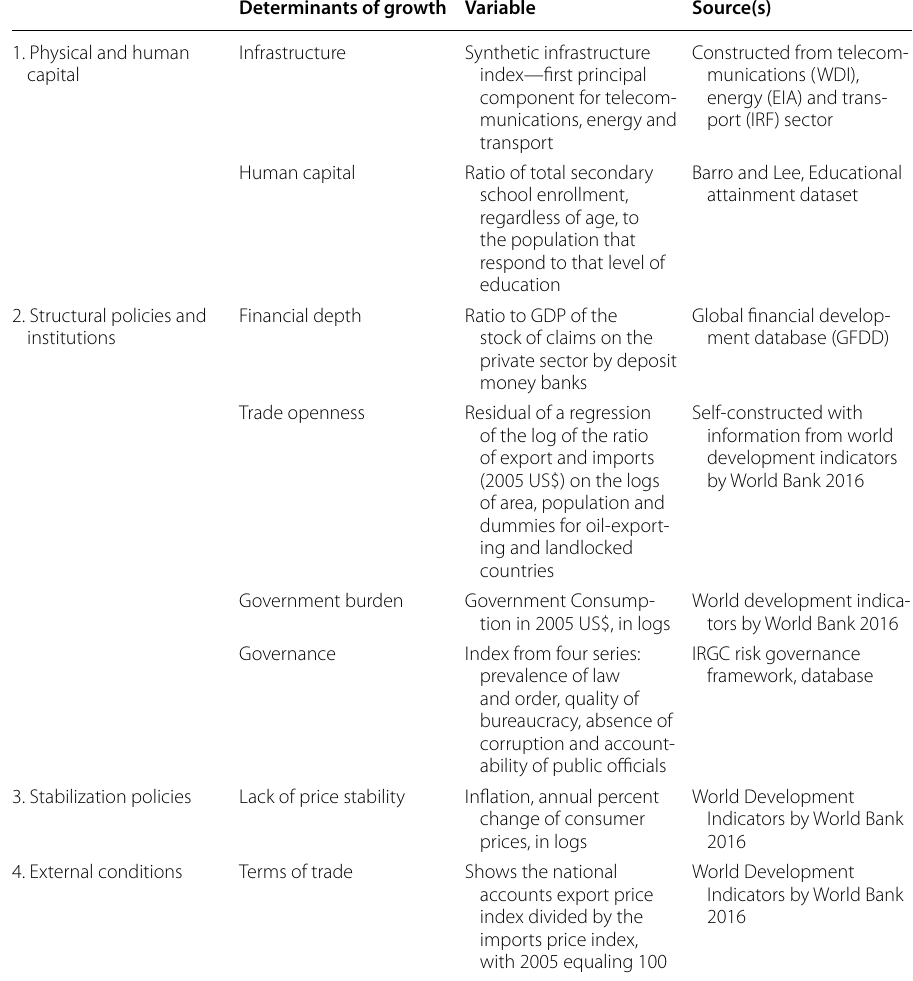
Table 2 Standard set of growth determinant variables Source : Adapted from Loayza et al.